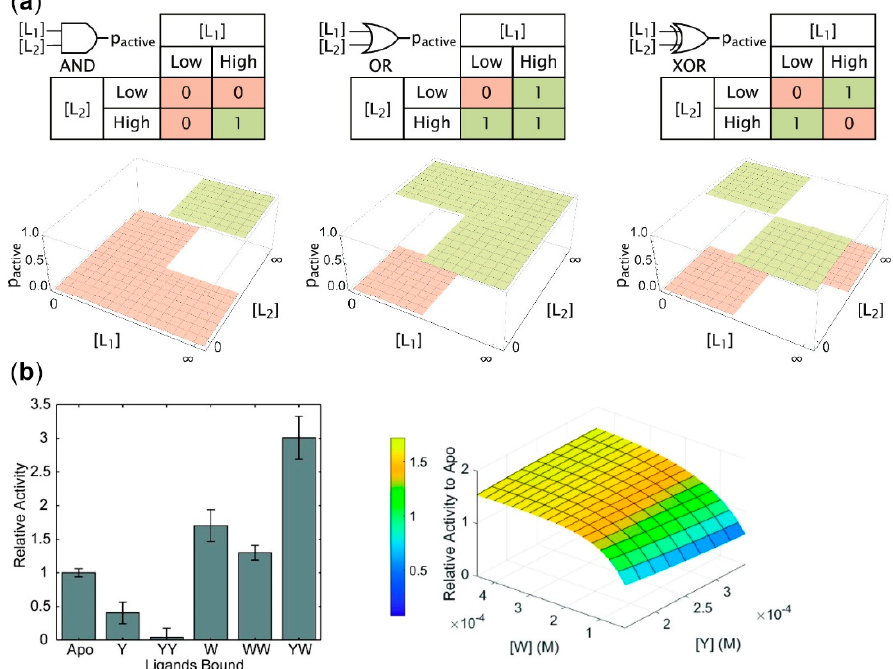
Figure 1. Allosteric enzymes as logic gates. ( a ) Binding of different allosteric modulators (L 1 and L 2 ) can result in different functional output (i.e., 0 for no or low enzyme activity; 1 for high enzyme activity). This panel is reprinted with permission from Galstyan, V., Funk, L., Einav, T., and Phillips, R. 2019. Combinatorial control through allostery. J. Phys. Chem. B., 123, 2792–2800. Copyright 2019 American Chemical Society [56]. ( b ) The functional landscape of Saccharomyces cerevisiae chorismate mutase (ScCM) is dependent on the concentration of the allosteric modulators tryptophan (W) and tyrosine (Y). ScCM is a homodimer in which the allosteric site binds W or Y (i.e., binding is mutually exclusive at each site). When ScCM binds Y at one site and W at the other site, ScCM displays the highest activity, which could be conceptualized as an AND gate. However, binding of Y alone leads to allosteric inhibition, providing complexity beyond the binary logic gates. This panel is reprinted with permission from Gorman, S.D. and Boehr, D.D. 2019. Energy and enzyme activity landscapes of yeast chorismate mutase at cellular concentrations of allosteric effectors. Biochemistry, 58, 4058–4069. Copyright 2019 American Chemical Society [49].